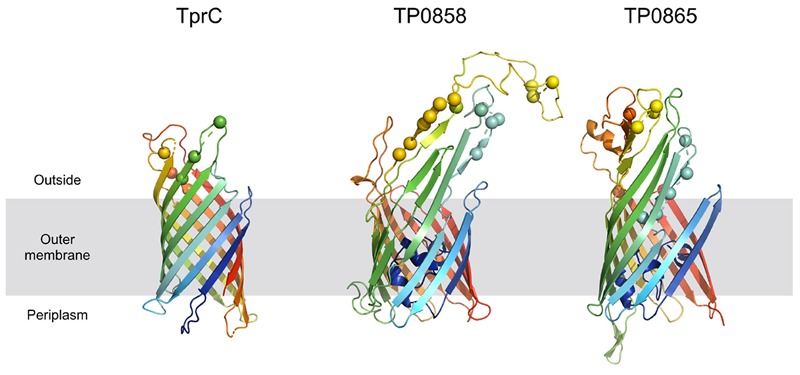
Homology models of TprC, TP0858, and TP0865. Homology models are shown in cartoon representation. The mutated residues are depicted with spheres. The models are colored based on a rainbow coloring scheme (with N-terminal of protein colored blue and C-terminal colored red).